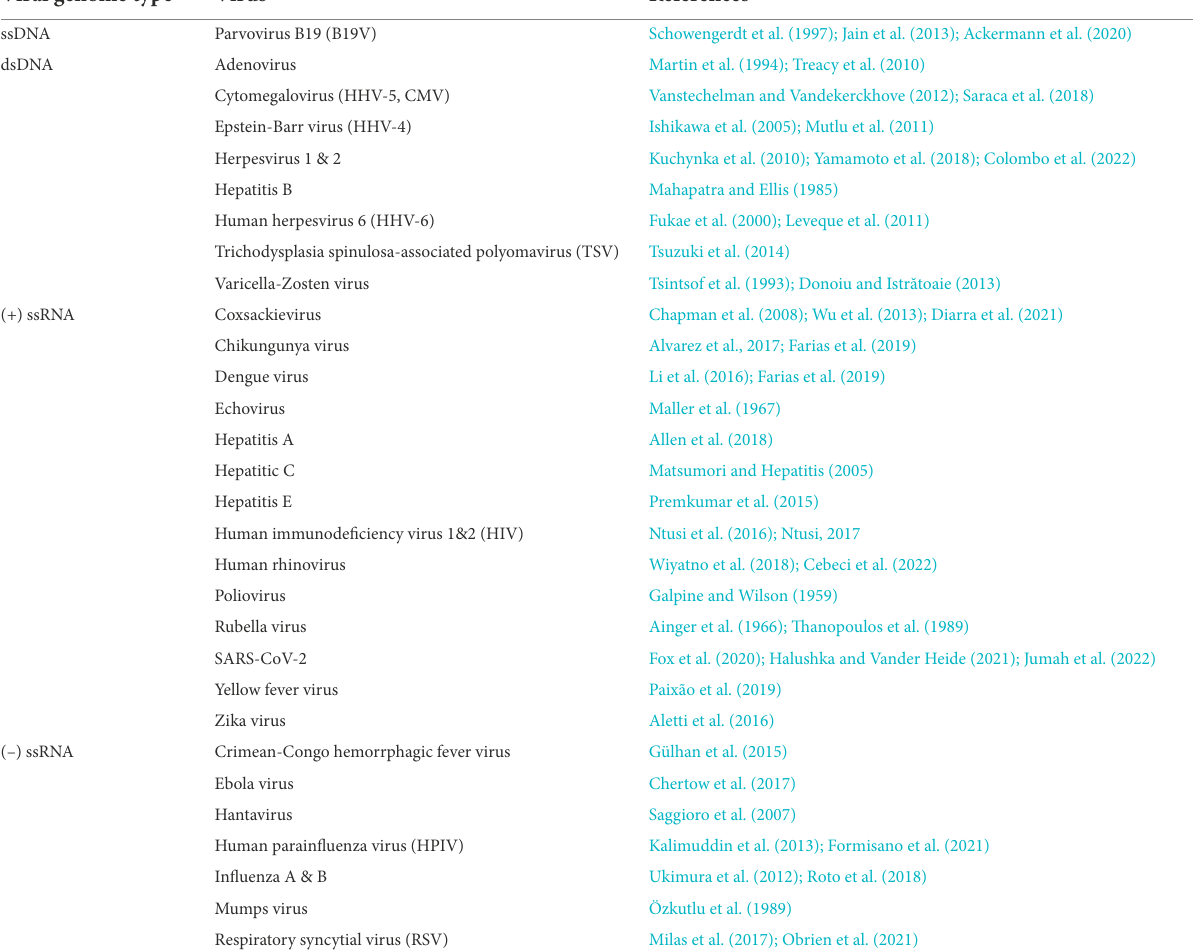
TABLE 1 Viruses previously reported to cause